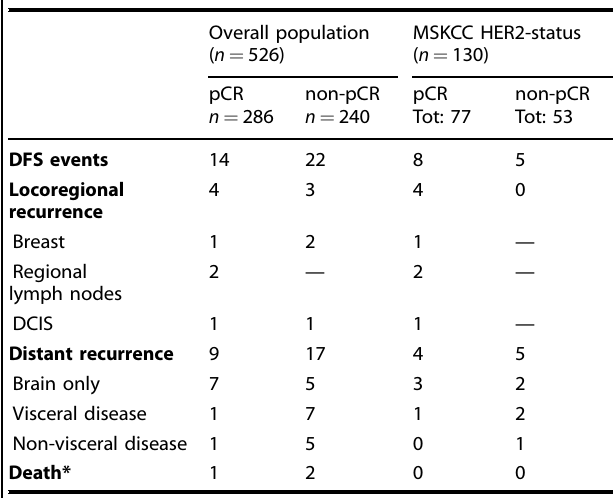
Table 2. Disease-free survival events: pCR versus non-pCR patients.